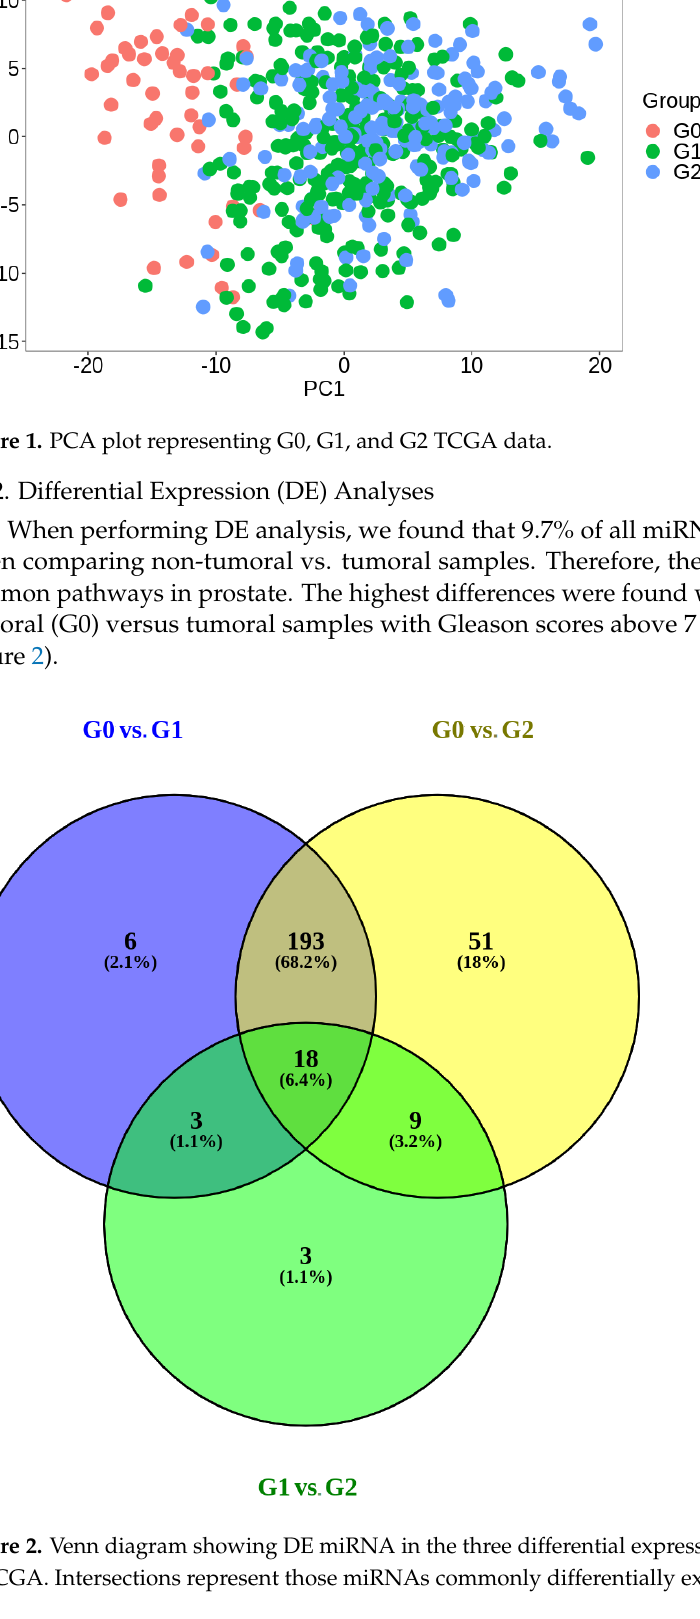
those miRNAs that are not differentially expressed contrasting with DE analysis, which is represented in red. Nearer to the left side are miRNAs under-expressed contrasting with those closer to the right side, which are over-expressed. Moreover, those miRNAs that are on the upper part of the Y axis had a stronger statistical significance. The most inter- esting miRNAs for the present work are identified as surrounded by a circle in Figure 3. We have also represented, using volcano plots, both comparisons, G0 versus G1 and G0 versus G2 (see details in Figures S2 and S3).